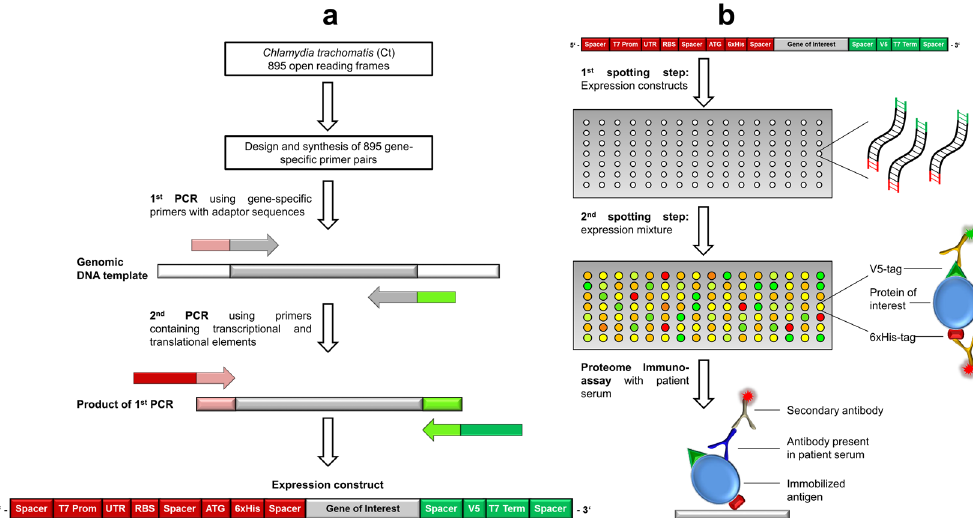
Figure 1. Generation of Ct whole-proteome microarrays. ( a ) In order to generate expression constructs, gene specific primer pairs were designed for all 895 Ct ORFs, including adaptor sequences common to all forward (pink) and reverse primers (light green). Using genomic Ct DNA as template, all 895 genes were amplified, resulting in PCR products carrying the gene of interest (GOI) flanked by two adaptor sequences. These products served as templates for a second PCR, using common primers for all Ct genes. These primers contain transcriptional and translational elements, as well as sequences complementary to the adaptor sequences. After the second PCR, genes were therefore flanked by spacer sequences, regulatory sequences (T7 Promoter, untranslated region (UTR), ribosome binding site (RBS), start codon (ATG), T7 Terminator) and N-terminal 6xHis and C-terminal V5 fusion tags (red: sequences included in the forward primer; green: sequences included in the reverse primer). ( b ) The expression constructs were transferred onto Ni-NTA coated slides in a first spotting step. Subsequently, the expression mixture was spotted directly on top of the first spots, and proteins were expressed on the slide during incubation in a humidified environment. Efficiency of protein expression was determined using fluorescence-conjugated antibodies directed against the terminal fusion tags. Proteome Immunoassays were performed by incubation of serum on whole-proteome arrays. Antibodies present in the serum were able to bind to the immobilized antigens on the array, and quantified using a fluorescence- conjugated anti-human secondary Proteome immunoassays (PIA). Human sera were pooled according to their pre-determined Ct serosta- tus and Ct DNA positivity, their age and CxCa case-control status. Since Ct infections are usually acquired at young age 25 , we hypothesized that young women are more likely to suffer from acute infections while older women have a higher probability of having developed persistent infections. Therefore, we additionally grouped the Ct-infected women according to their age. As a pilot study, we incubated 22 pools of each five sera on the whole-proteome array: two Ct-uninfected, twelve Ct-infected cancer-free, and eight Ct-infected CxCa pools. Binding of serum antibodies to antigens immobilized on the microarray was detected by a secondary fluorescence-conjugated anti-human antibody. Typical results of PIAs are shown in Fig. 3. Sera from uninfected women (negative for both genital Ct DNA and pre-determined overall Ct antibody status) did not show positive signals with any of the Ct proteins (Fig. 3a), while all serum pools of Ct-infected women revealed positive signals (Fig. 3b–e). Besides the identification of novel antigens, we were able to confirm known immunogenic Ct proteins that are already used in many serological assays such as the plasmid encoded pGP3 and CT_681 (major outer membrane protein, MOMP). Comparison of the antibody reactivity patterns indicated that there were antigens which reacted with all Ct seropositive pools but also antigens which reacted only with serum pools from cancer patients. Interestingly, we observed some antigens reacting only with pools of sera from women of higher age, possibly indicating persistent Ct infections. None of the Ct positive sera analyzed on the whole-proteome array showed reactivity with Cp MOMP, and only few sera showed low reactivity with the MOMP of serovars A and L2. Supplementary Figure S2 illustrates the results of all 22 PIAs. In order to exclude a concordance between PIA signals and signals obtained during determination of on-chip protein expression both signals were compared by linear regression. Correlation coefficients below 0.05 across 20 Ct seropositive serum pools revealed no correlation between protein expression levels and immunoassay signals. In fact, some Ct proteins with very low expression signals revealed high MFI with some serum pools. Therefore, immunoassay signals were not normalized for their respective expression signals. Both protein expression staining and PIA showed overall good reproducibility in independent experiments (Fig. 4). A correlation coefficient of 0.77 revealed good reproducibility for the expression staining (Fig. 4a). Reproducibility of immunoassays was particularly high (r = 0.96) when performed with microarrays produced in a single production batch (Fig. 4b). Variation was only slightly higher when the microarrays were produced in different batches (r = 0.89, Fig. 4c).